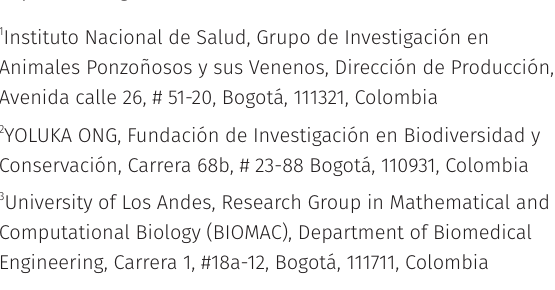
Table SI. Taxonomic treatment and criteria used to allocate the puzzling snake species posted by Facebook users. Table SII. Species list summarizing the posts-feedback. Table SIII. Alimentary items recorded in the Facebook posts. Table SIV. Snakebite accident reported by Facebook users. Table SV. Distribution extensions derived from Facebook posts of Colombian snake species reported in the Global Biodiversity Information Facility (GBIF). Records that fall outside the 50-km buffer around available GBIF records. Table SVI. Distribution extensions derived from Facebook posts of Colombian snake species reported in the Global Biodiversity Information Facility (GBIF).